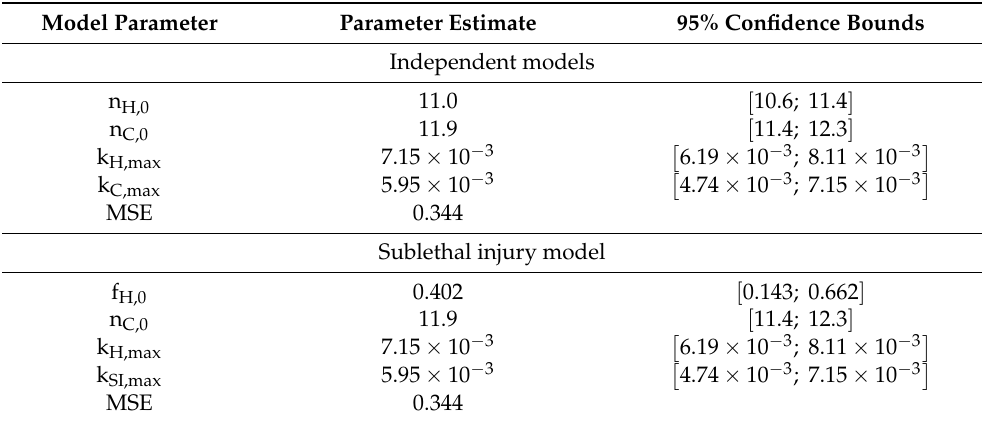
Table 1. Parameter estimation results from fitting the independent models (Equations (21) and (22)) and sublethal injury model (Equations (19) and (20)) based on log-linear inactivation on Dataset 1. Model